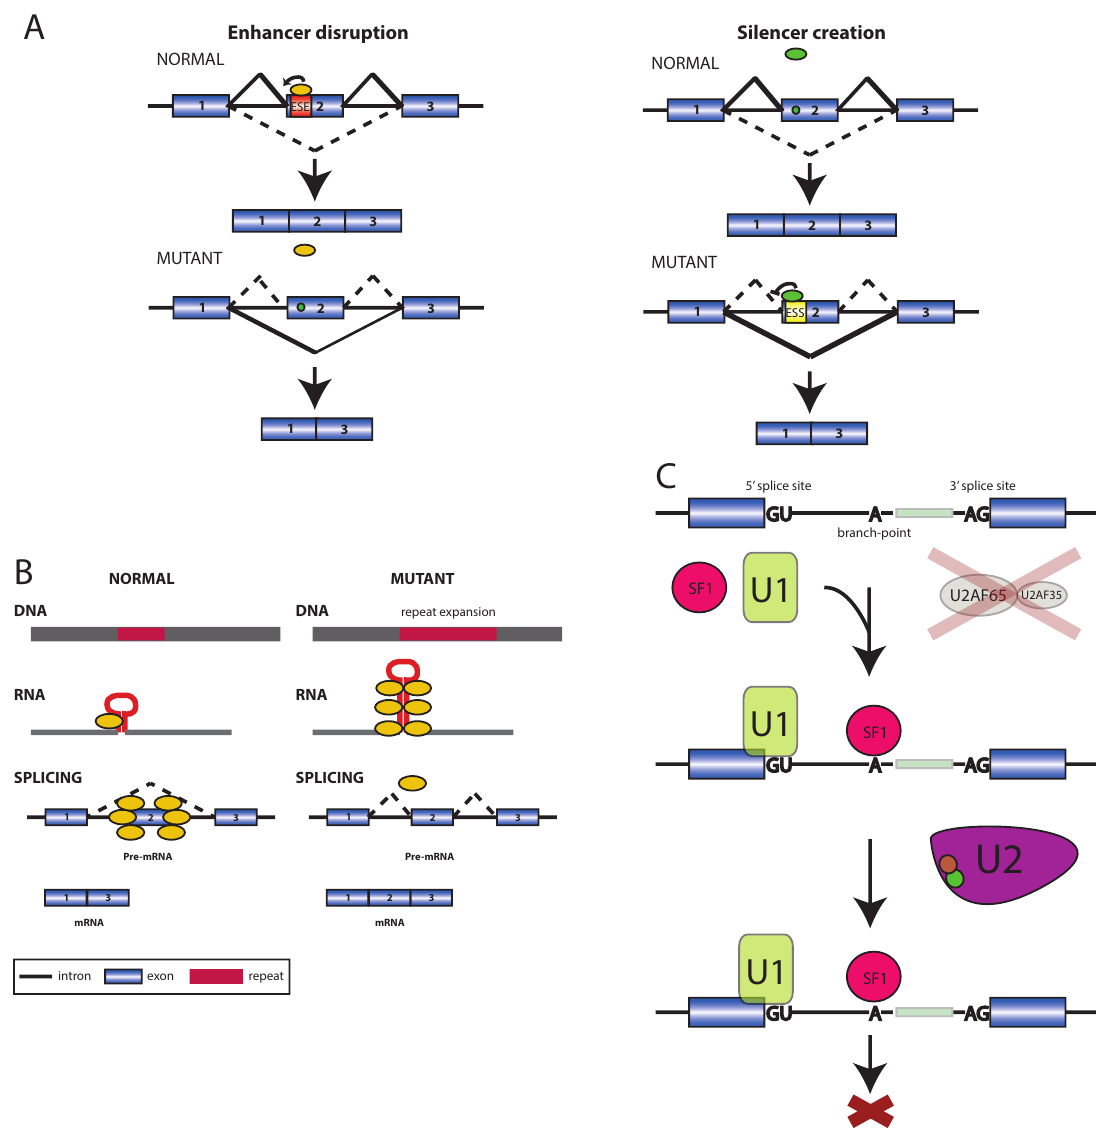
Figure 2: Three mechanisms of RBP-caused splicing dysregulation. A) Disruption and/or creation of cis-elements by disease variants.